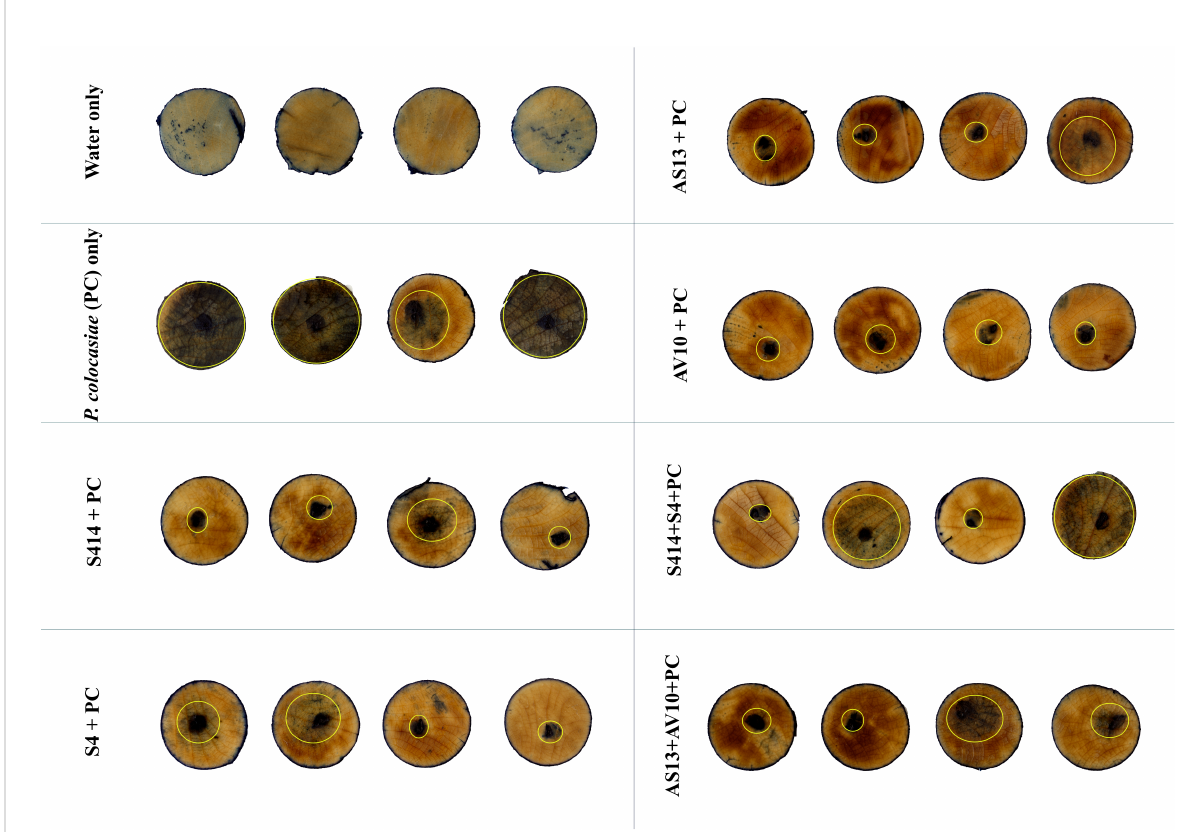
FIGURE 5 Trypan blue staining of detached taro leaves showing the biocontrol ef fi cacy of selected bacterial strains against Phytophthora colocasiae . Taro leaf tissue uninfected by P. colocasiae showed no staining, or isolated speckles. The positive control for P. colocasiae infection showed strong trypan blue staining that extended beyond the inoculation site. Treatment with biocontrol bacteria limited infection by P. colocasiae , evidenced by no trypan blue staining beyond the initial inoculation site. Yellow circles indicate the limit of P. colocasiae disease